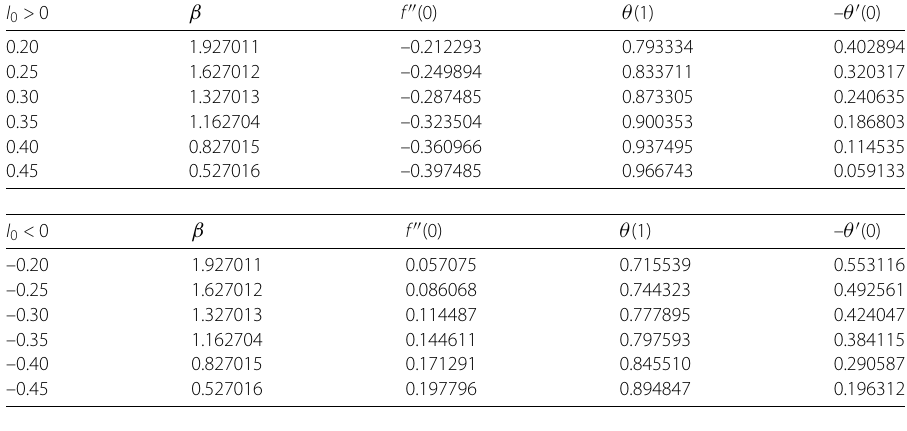
Figure 7 The effect of β on velocity profile with λ = 0.2, I 0 = 0, A = 0.3, N = 0.2, S = 0.4, Ma = 1, M = 1, Pr = 1, Υ =